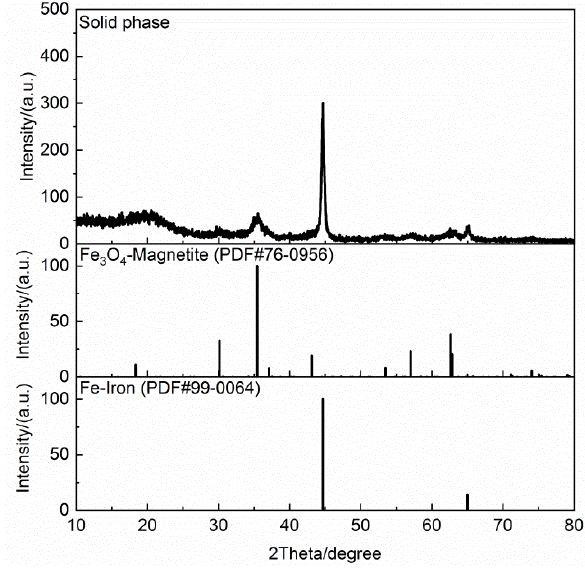
Figure 2. XRD pattern of the solid phase in the dried cold-rolling oily sludge.